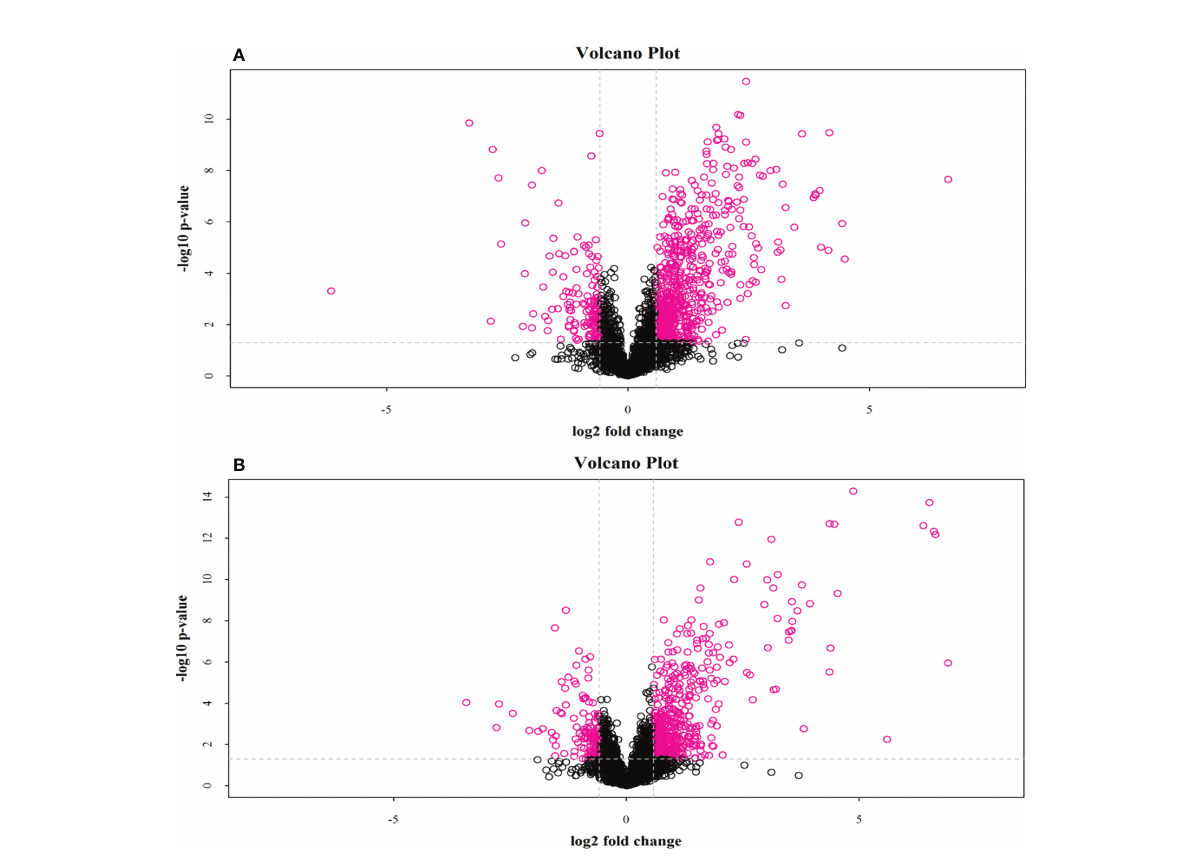
FIGURE 6 Volcano plot of positive and negative ion mode data. The red dots in the fi gure are metabolites with FC > 1.5 and P value < 0.05, (A) , positive ion mode; (B) , negative ion mode, i.e., the differential metabolites screened by univariate statistical